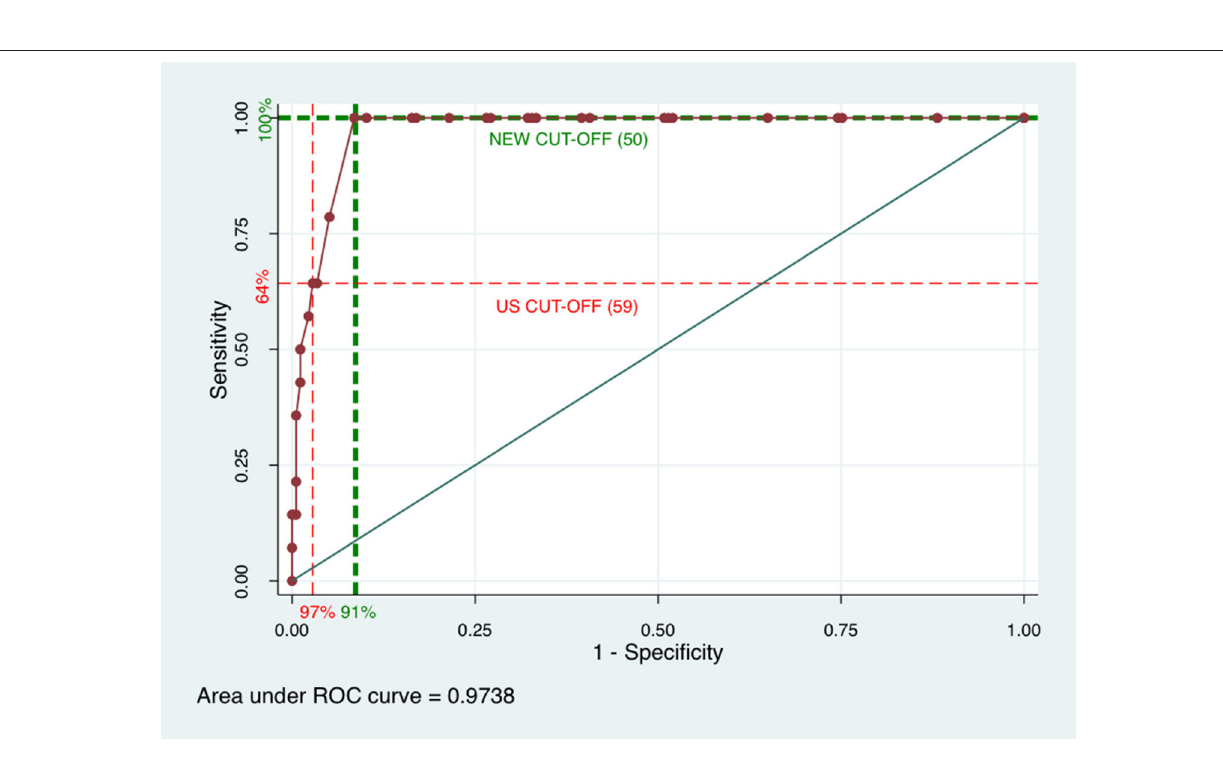
Frontiers in Pediatrics |